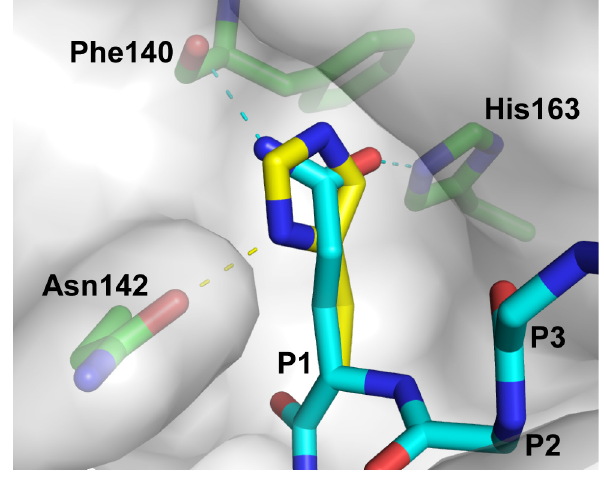
Figure 4. Modeling how 3CL pro recognizes P1-His. In the 3CL pro - substrate complex (PDB: 2Q6G), amide group of P1-Gln of the WT substrate sequence (thin stick) forms hydrogen-bonds with the N e 2 atom of His163 and the backbone carbonyl group of Phe140. P1-Gln was substituted to His (thick stick) in silico using the program SWISS- PDBViewer [24]. The rotamer of P1-His was selected to avoid steric hindrance and to optimize for hydrogen bond formation. The modeled structure was then energy minimized using a GROMOS force-field implemented in SWISS-PDBViewer. It was found that P1-His can fit into the substrate binding pocket and form hydrogen bond to the amide group of Asn142.